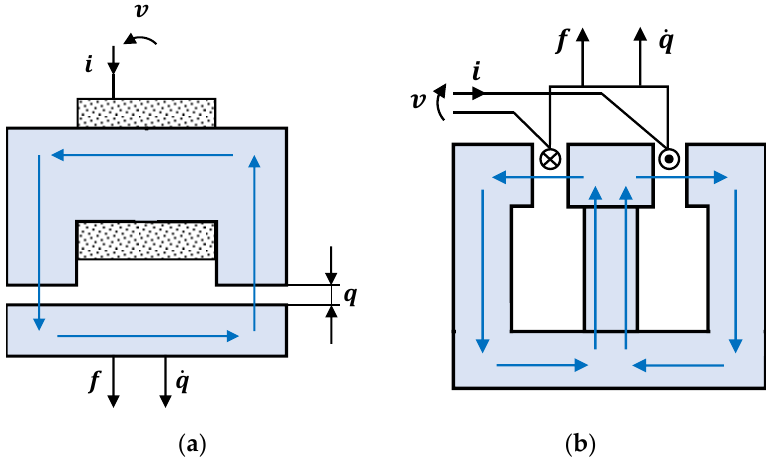
Figure 23. ( a ) Maxwell magnetic actuator and ( b ) Lorentz magnetic actuator.